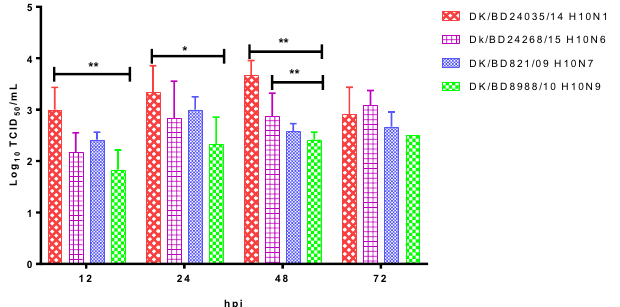
Figure 5. Growth characteristics of H10 AIVs in A549 cells. A549 cells were inoculated at a multiplicity of infection of 0.01 TCID 50 /cell with the DK/BD821/09 H10N7, DK/BD8988/10 H10N9, DK/BD24035/14 H10N1, or Dk/BD24268/15 H10N6 AIVs. Supernatants were collected at the indicated time points and titrated in MDCK cells by TCID 50 . Error bars depict standard deviations. * P < 0.05, ** P <